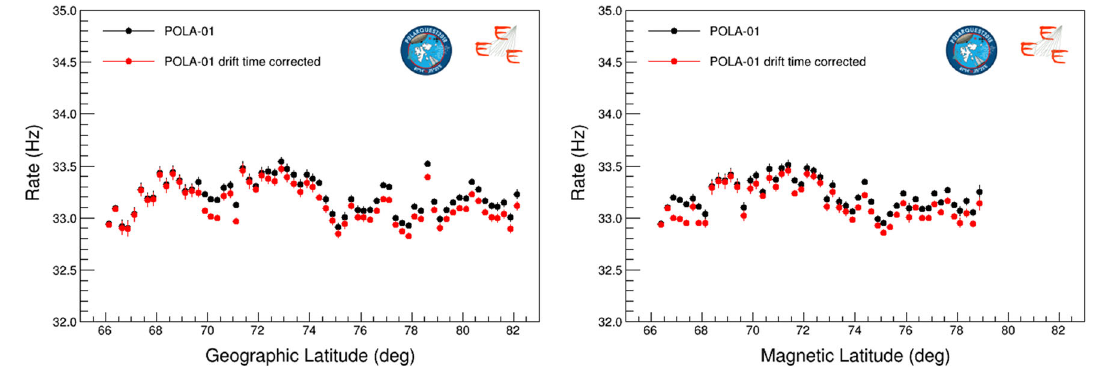
Fig. 28 Rate measured by POLA-01 as a function geographic (left) and magnetic (right) latitude, before (black points) and after long term drift correction (red points)